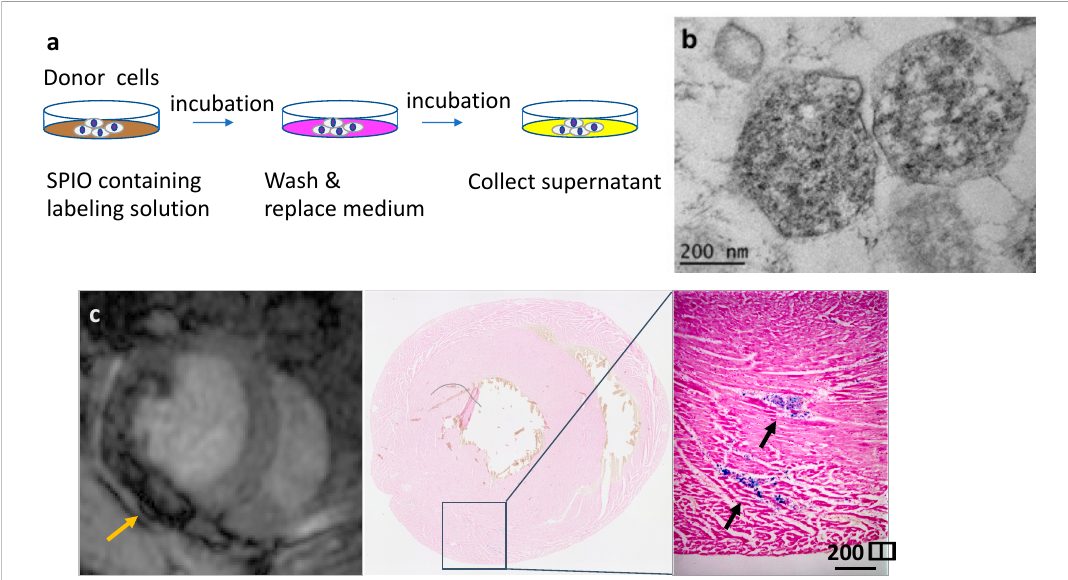
Figure 3. ( a ) The diagram of the method of labeling with SPIO. ( b ) Transmission electron microscopy of labeled extracellular vesicles (EVs). SPIO are detected as black particles inside the vesicles. ( c ) In vivo magnetic resonance imaging (MRI) detection of SPIO labeled EVs injected in the mouse heart (left). The image was acquired with a GE 3.0T Signa scanner. Prussian blue staining of the slice from the excised heart (middle) proved the iron oxide particles stained blue in the myocardium (right: high magnification). [Unpublished data].